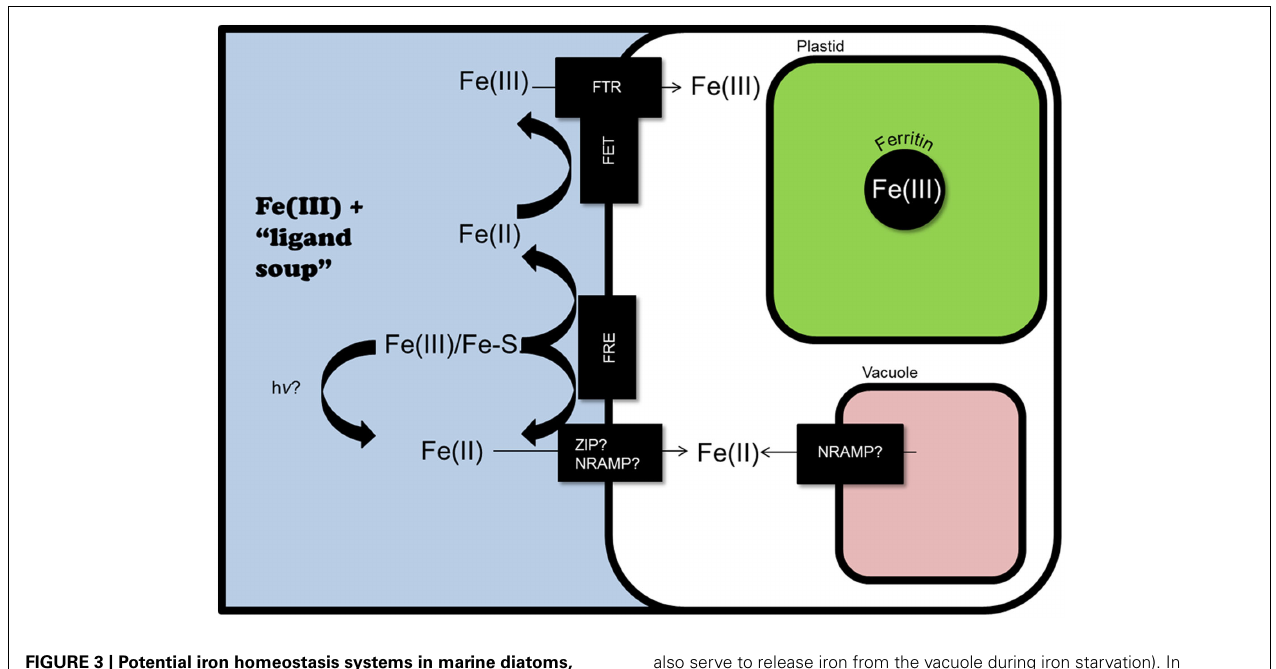
FIGURE 3 | Potential iron homeostasis systems in marine diatoms, as predicted by genomic analyses. Iron-regulated ferric reductase genes have been identified in T. pseudonana and P. tricornutum .These could reduce Fe(III) and Fe bound by siderophores (Fe–S), as could photoreduction (h v ). Fe(II) could then enter the cytoplasm through iron-regulated transporters: ZIP in P. tricornutum , and NRAMP in T. pseudonana (although ifTpNRAMP is localized to the tonoplast, it could